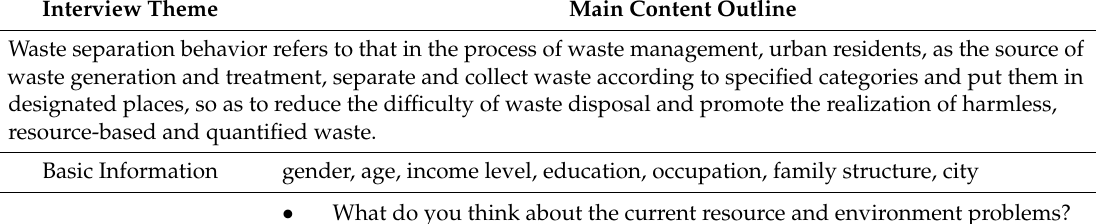
Table 1. Interview outlines and survey